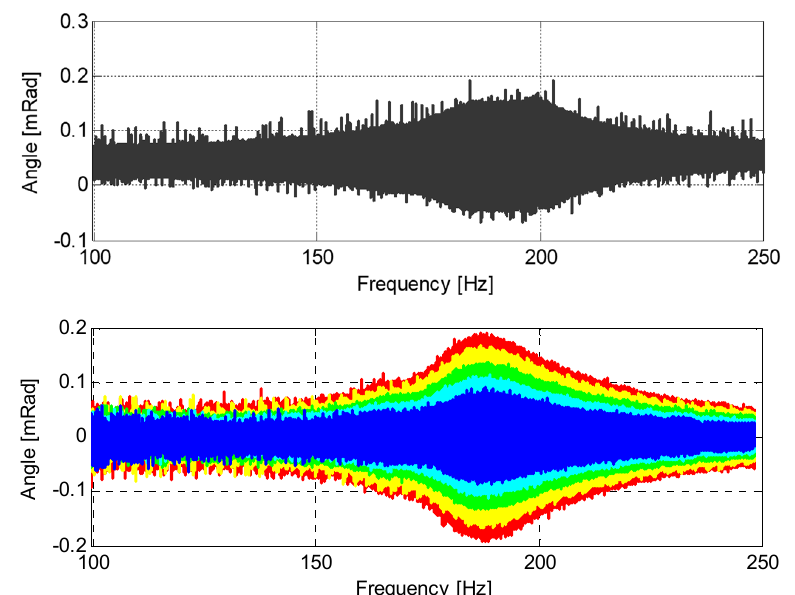
Figure 22. The results of RC testing. Standard RC test results are at the top; the results from the additional accelerometers are at the bottom. Material: saclSi 1; Isotropic pressure 100 kPa; Frequency spectrum 100–250 Hz; Excitation (torque) amplitude 0.5 V (– original built-in sensor, – the top sensor, S1, – the second sensor from the top, S2, – the third sensor from the top, S3, – the fourth sensor from the top, S4, – the bottom sensor, S5).